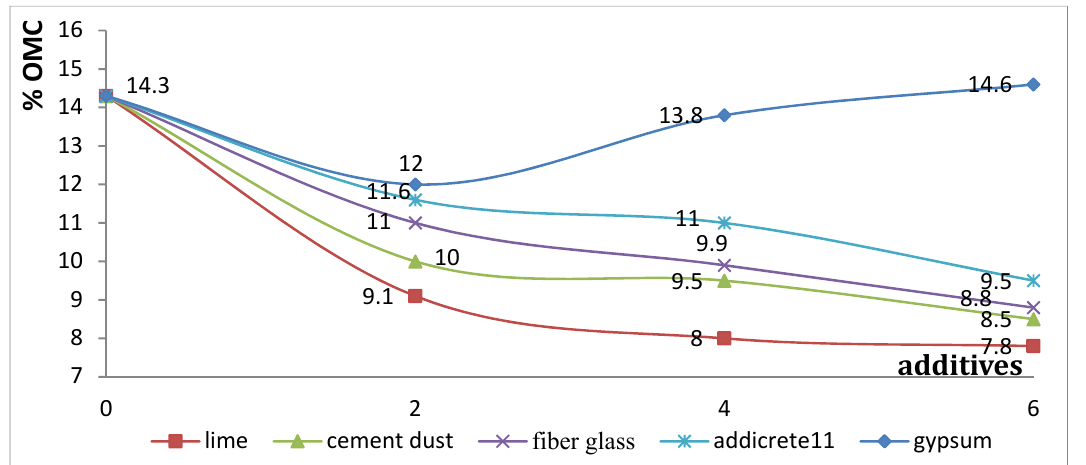
Figure 21. Effect of additives on optimum moisture content.